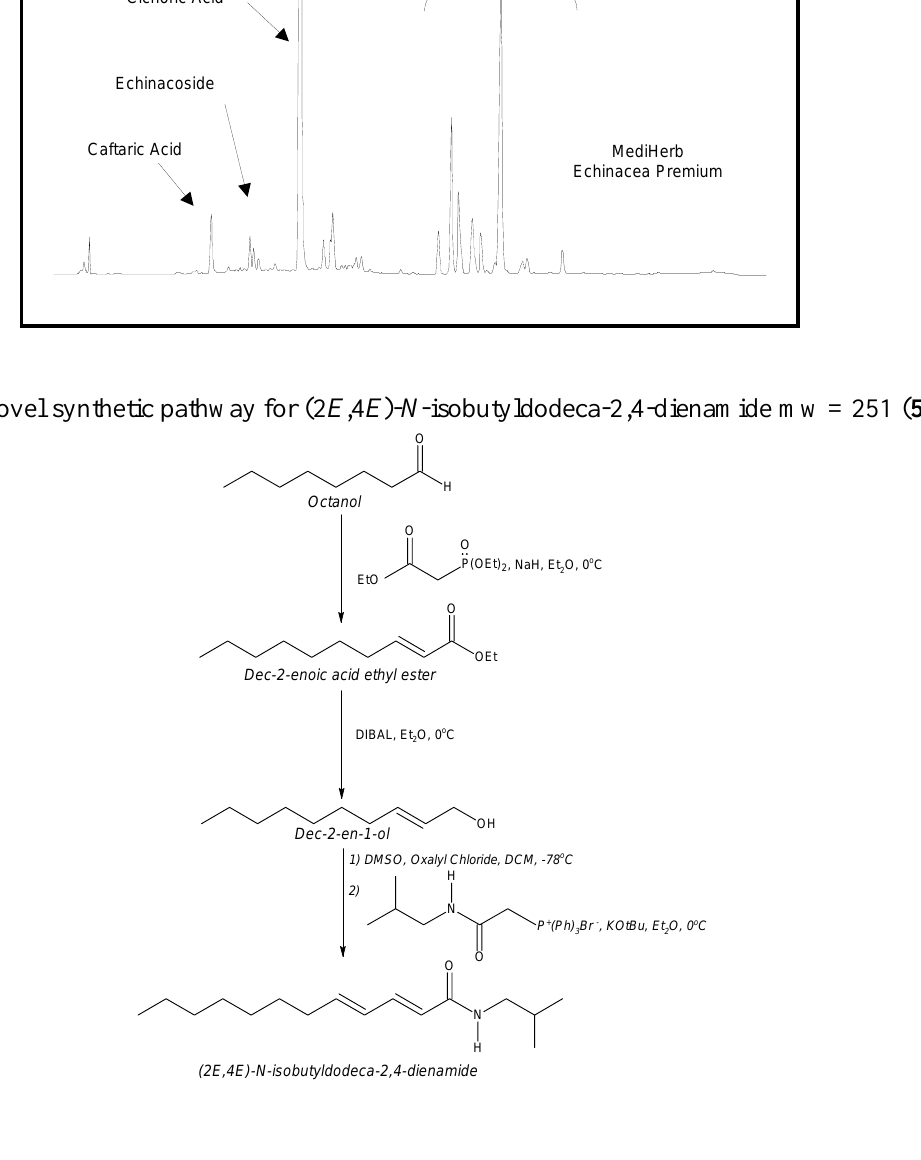
Figure 1: HPLC trace of an ethanolic Echinacea preparation containing Echinacea angustifolia and Echinacea purpurea root. The elution gradient was ramped from 30 to 100% acetonitrile:50 mM phosphoric acid over 55 minutes.